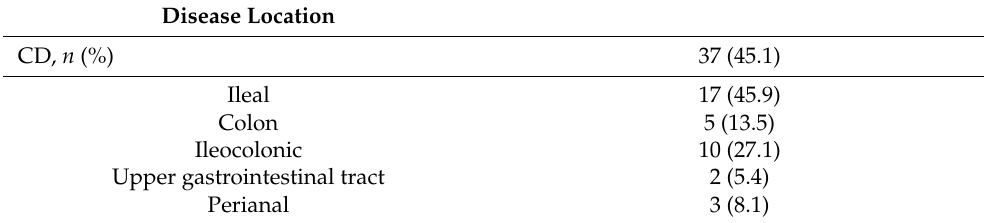
Table 1. Disease